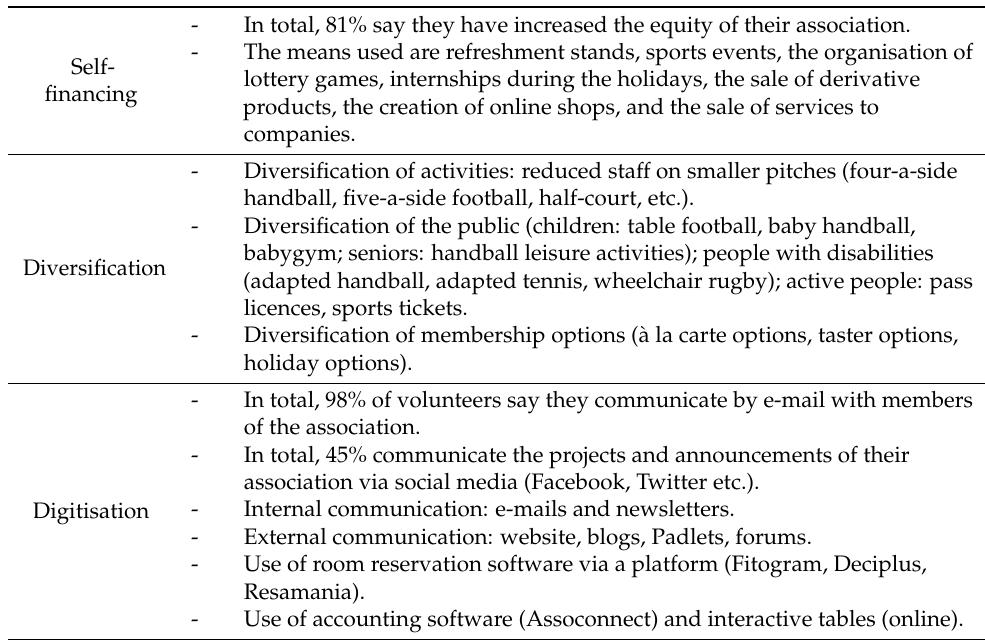
Table 1. Tools and materials for the managerial isomorphism of